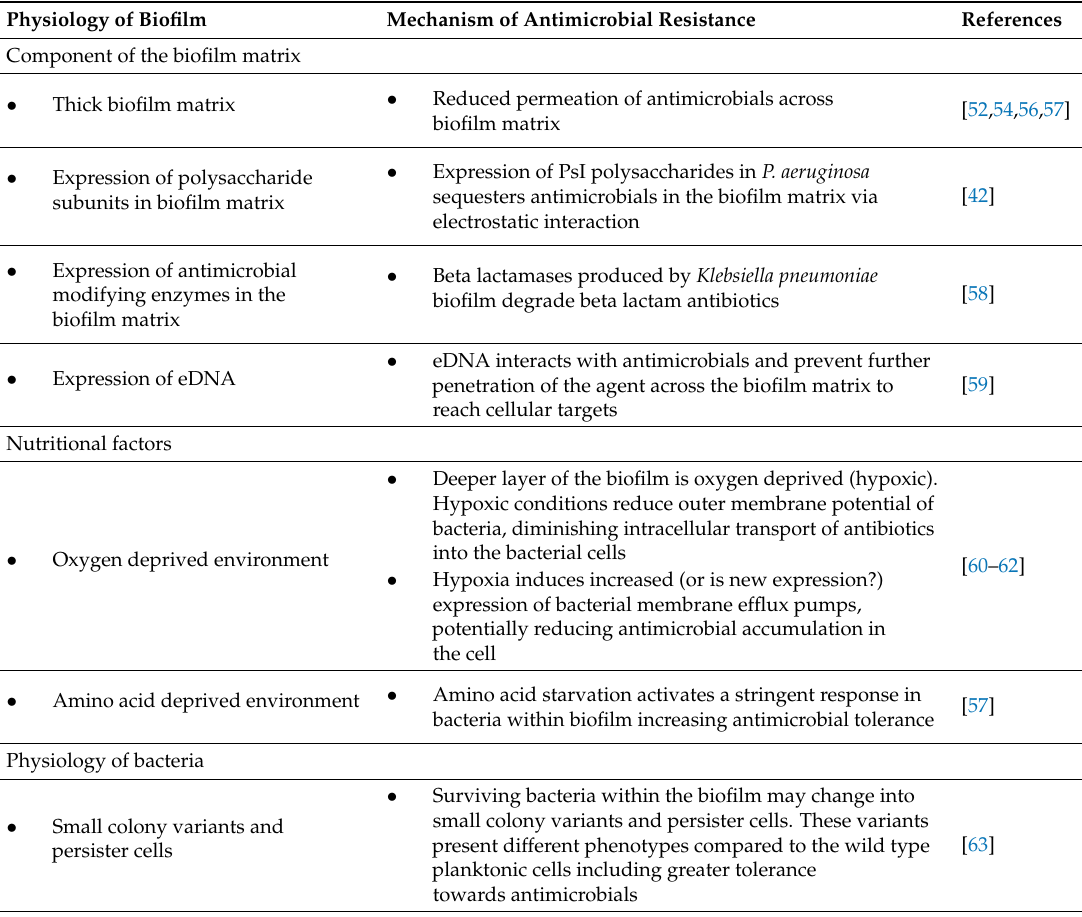
Table adapted from Hall & Mah (2017)